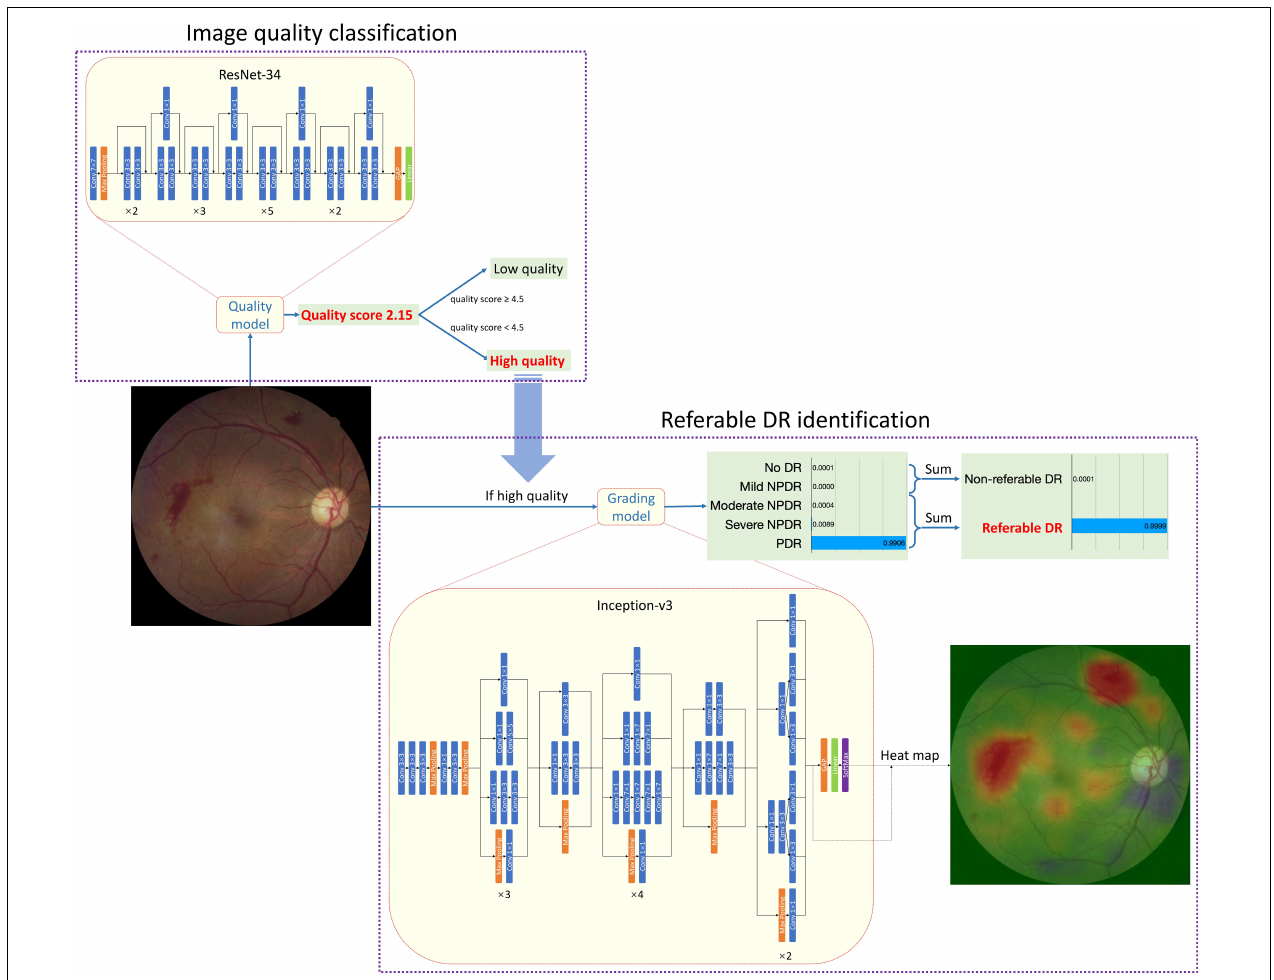
FIGURE 1 | The network architecture of EyeWisdom